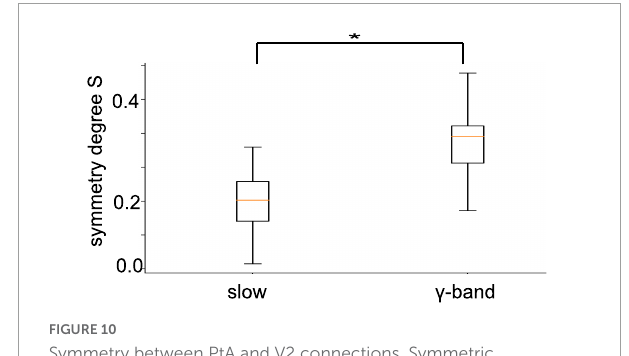
FIGURE10 Symmetry between PtA and V2 connections. Symmetric synchronization (defined in section “2. Materials and methods”, Eq. 1) is significantly more prominent in the γ -frequency than in low-frequency oscillation ( p < 10 – 8, α = 0.05). The horizontal bar with the star denotes statistically different median values between both frequency